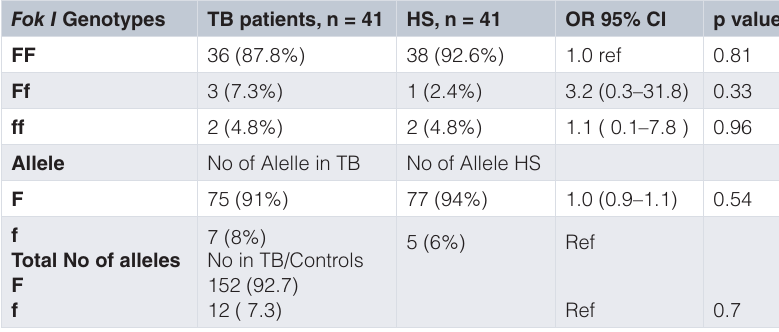
Dataset 1. Human VDR fokI gene nucleotide sequences